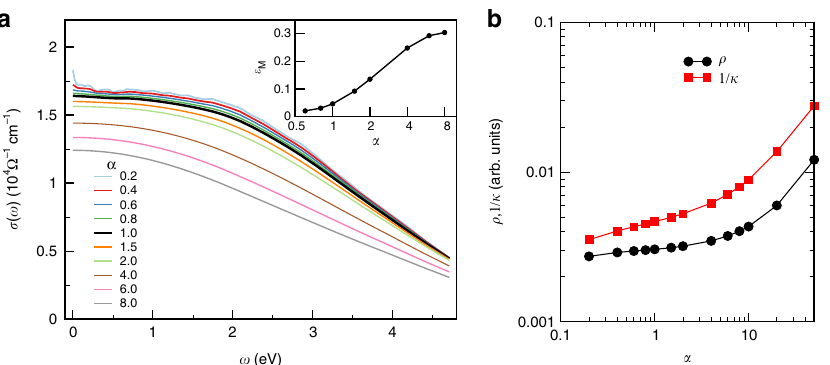
Fig. 4 Electron – electron scattering and Matthiessen ’ s rule in body-centered cubic Fe. a The optical conductivity of a representative body-centered cubic 3 × 3 × 3 supercell vs. scale factor α applied to the imaginary part of dynamical mean- fi eld-theory (DMFT) self-energy. The inset shows the relative deviation of calculated thermal conductivity from the Matthiessen ’ s rule as a function of α . b Calculated thermal and electrical resistivity as a function of the scale factor α . Notice the slow dependence in the vicinity of α